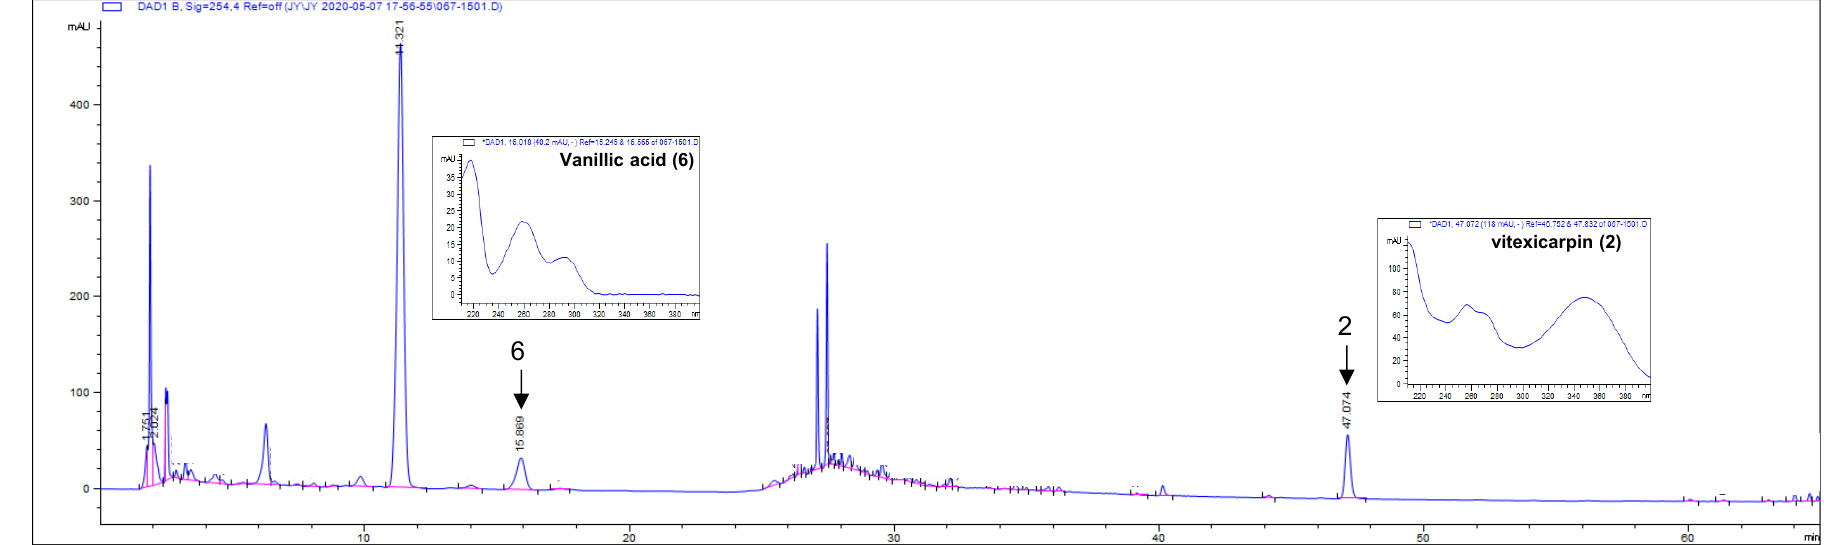
Figure 2. HPLC-UV/PDA chromatogram of 30% aqueous EtOH extract of V. rotundifolia